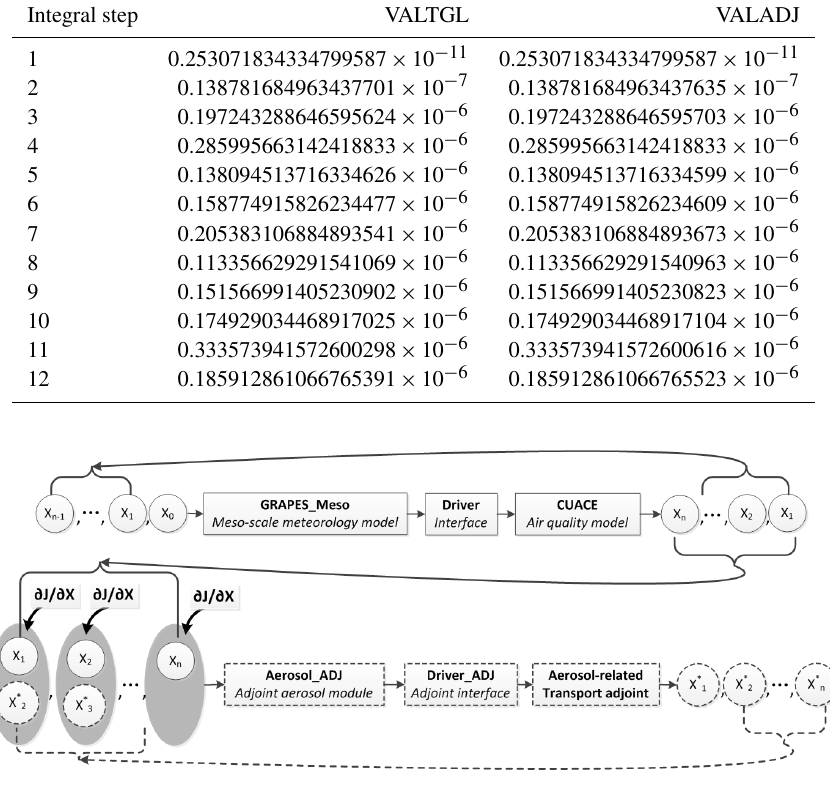
Figure 1. Flow chart of GRAPES–CUACE, aerosol adjoint, and the flowchart of the parameters transmission process.